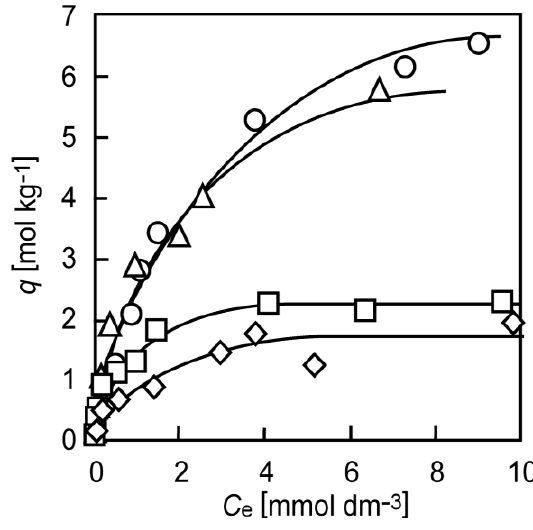
Figure 11. Adsorption isotherms of chromium(VI) on CPW gel [23] (with permission for reuse from Elsevier B.V.). ○ pH 1, ∆ pH 2, □ pH 3, ◊ pH